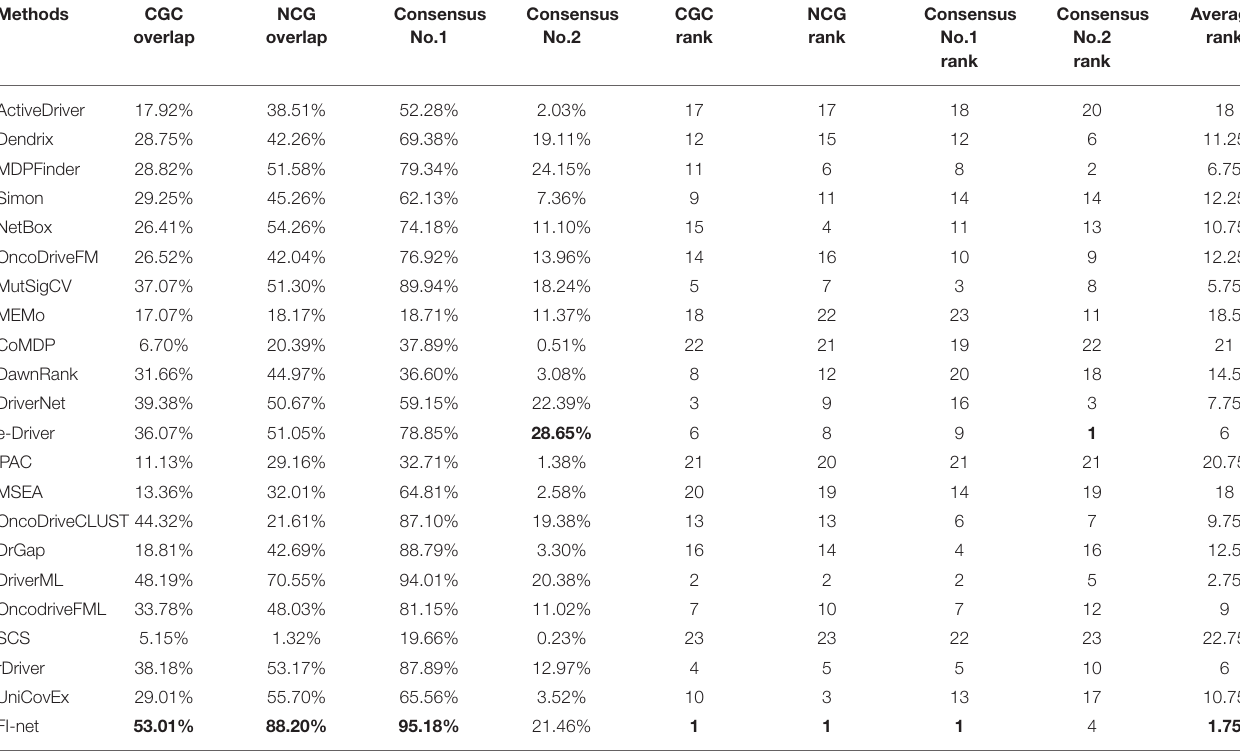
TABLE 1 | Overall performances of 22 driver gene prediction methods on 31 TCGA datasets.